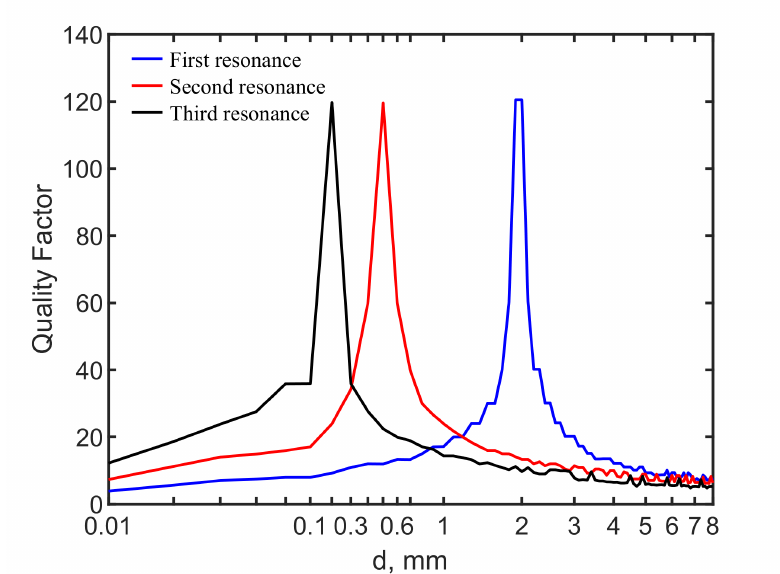
Figure 8. Quality factor as a function of spacing distance between the metal pad and loop d . Quality factor reaches the maximum of 120.5 for the first resonance when d = 1.9. mm. For second and third resonances, the maximum quality factors are 119.6 and 119.5 when d = 0.5 and 0.2 mm, respectively.